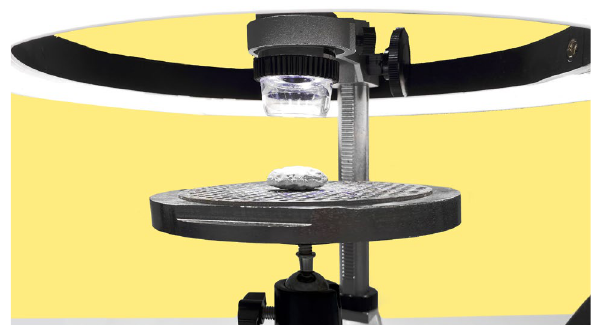
Figure 5 . Detail of the lighting ring coaxial to the rotating base, on which the calibrated plate is mounted.